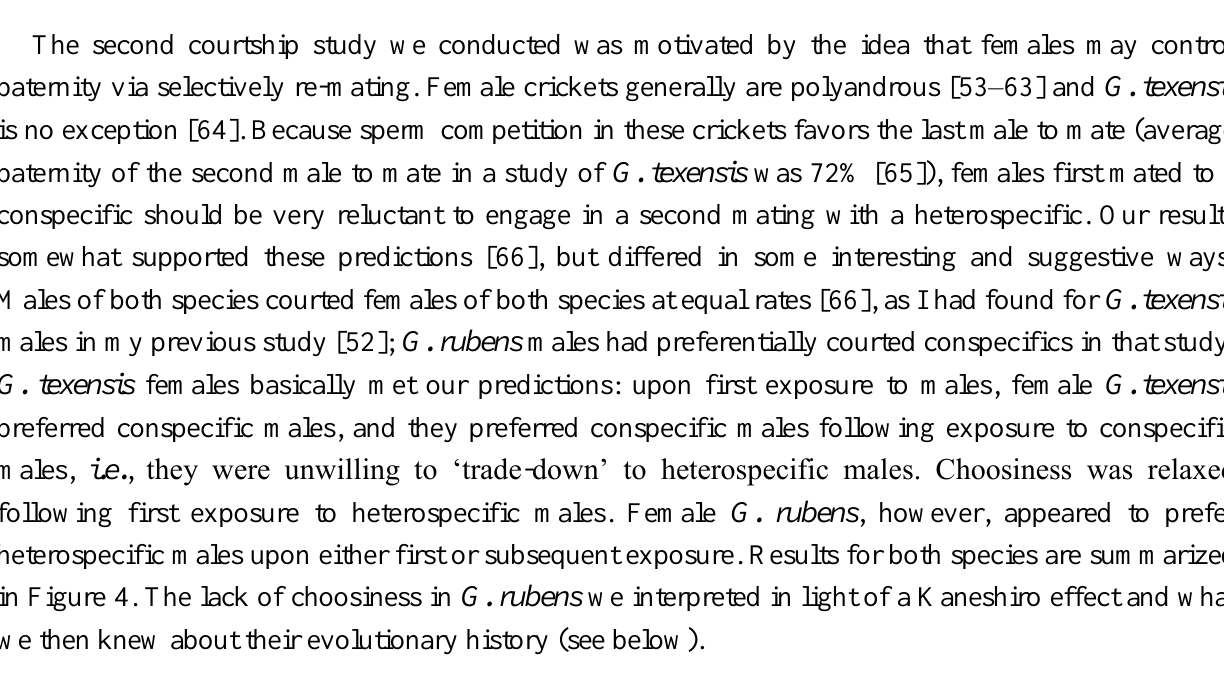
Figure 4. Female responsiveness to males in sequential mating trials in which the